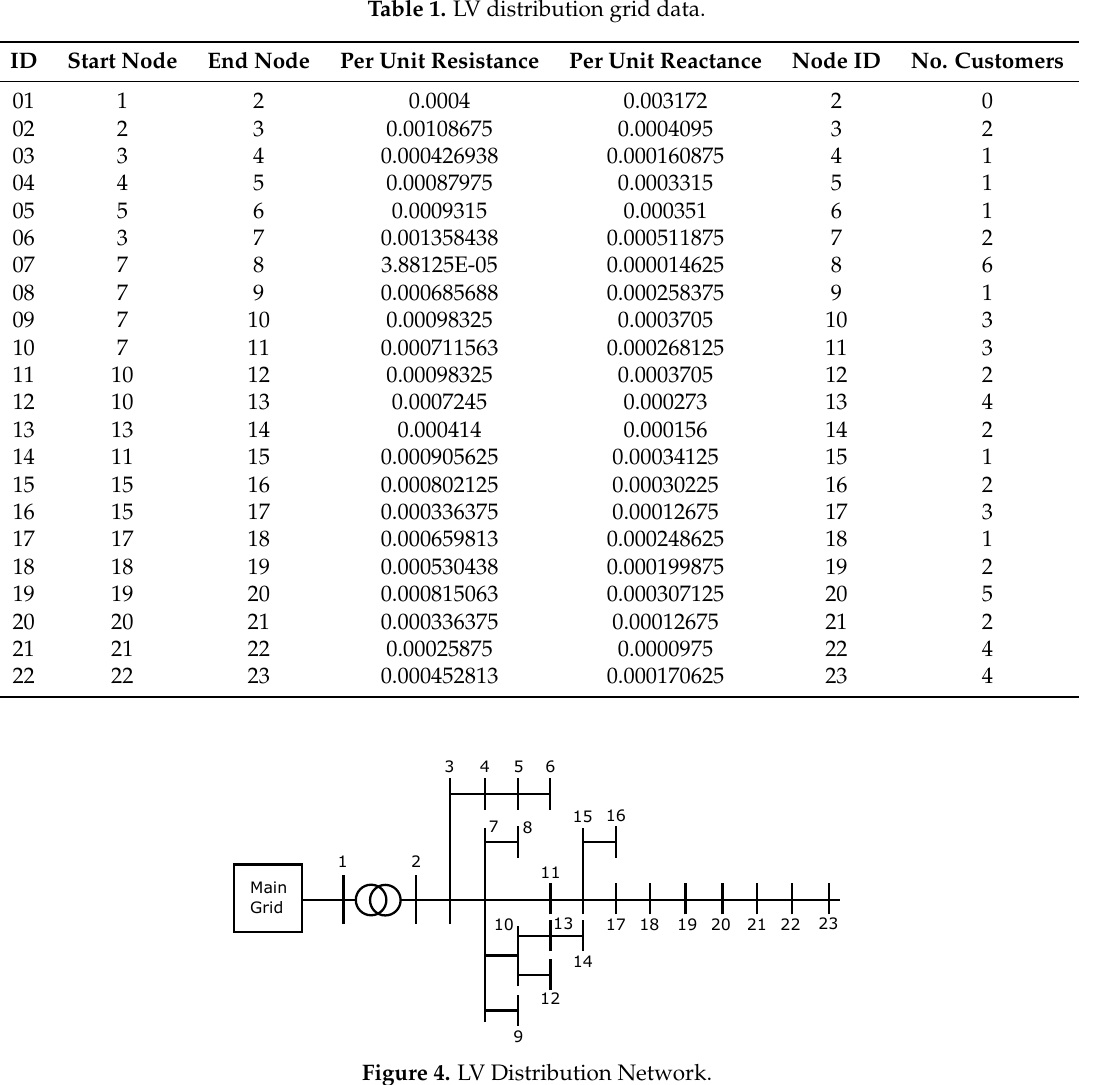
Table 1. LV distribution grid data.